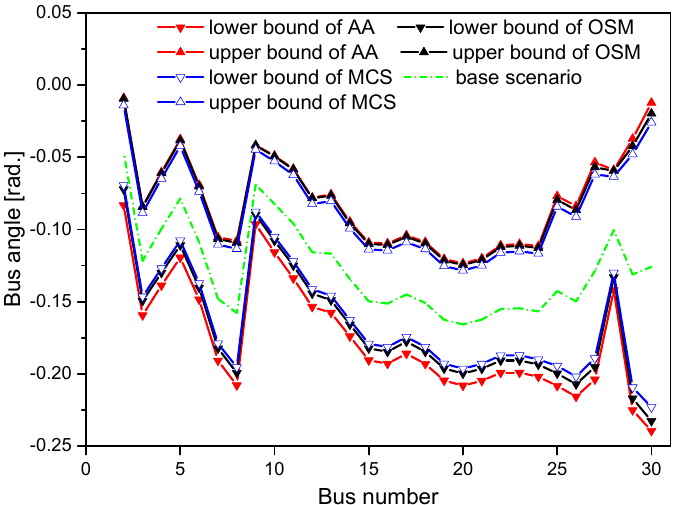
Figure 7. Ranges of bus angles acquired by three different methods.